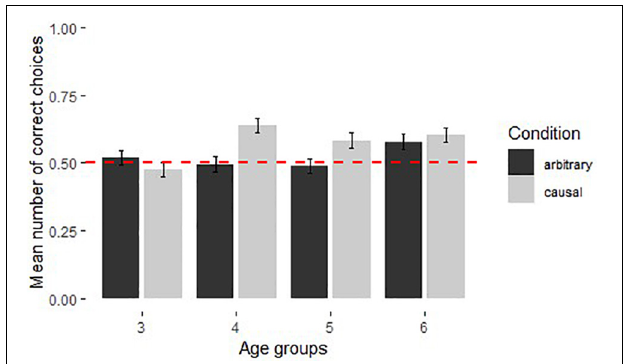
FIGURE 2 | Performance of children in the causal and arbitrary conditions in Experiment 1 ( N = 129, see Table 1 for age group information and means). Dotted line shows chance level performance ( p = 0.05), error bars represent SE .